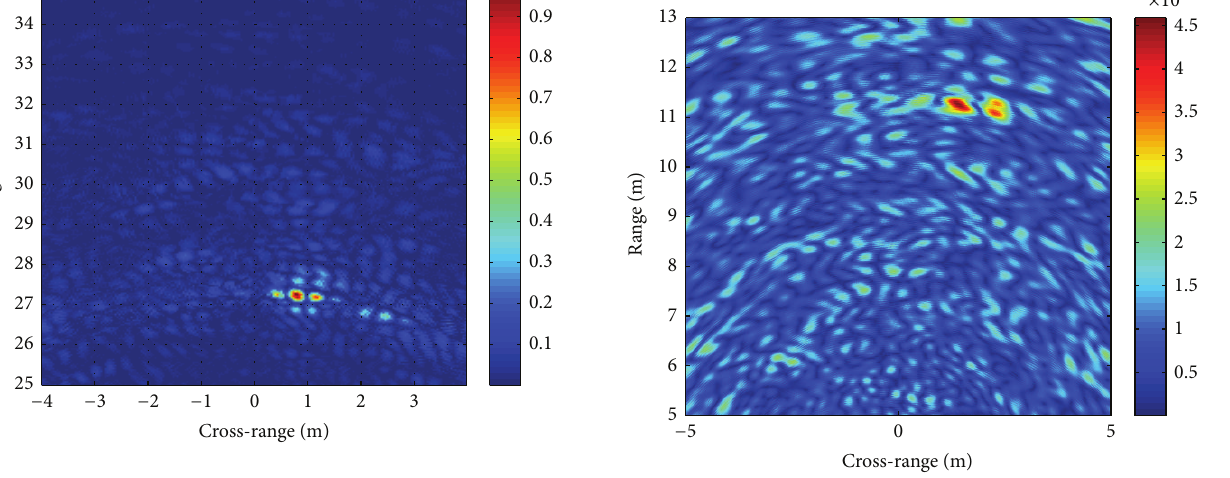
Figure 18: The original imaging result by the standard differential BP imaging algorithm.